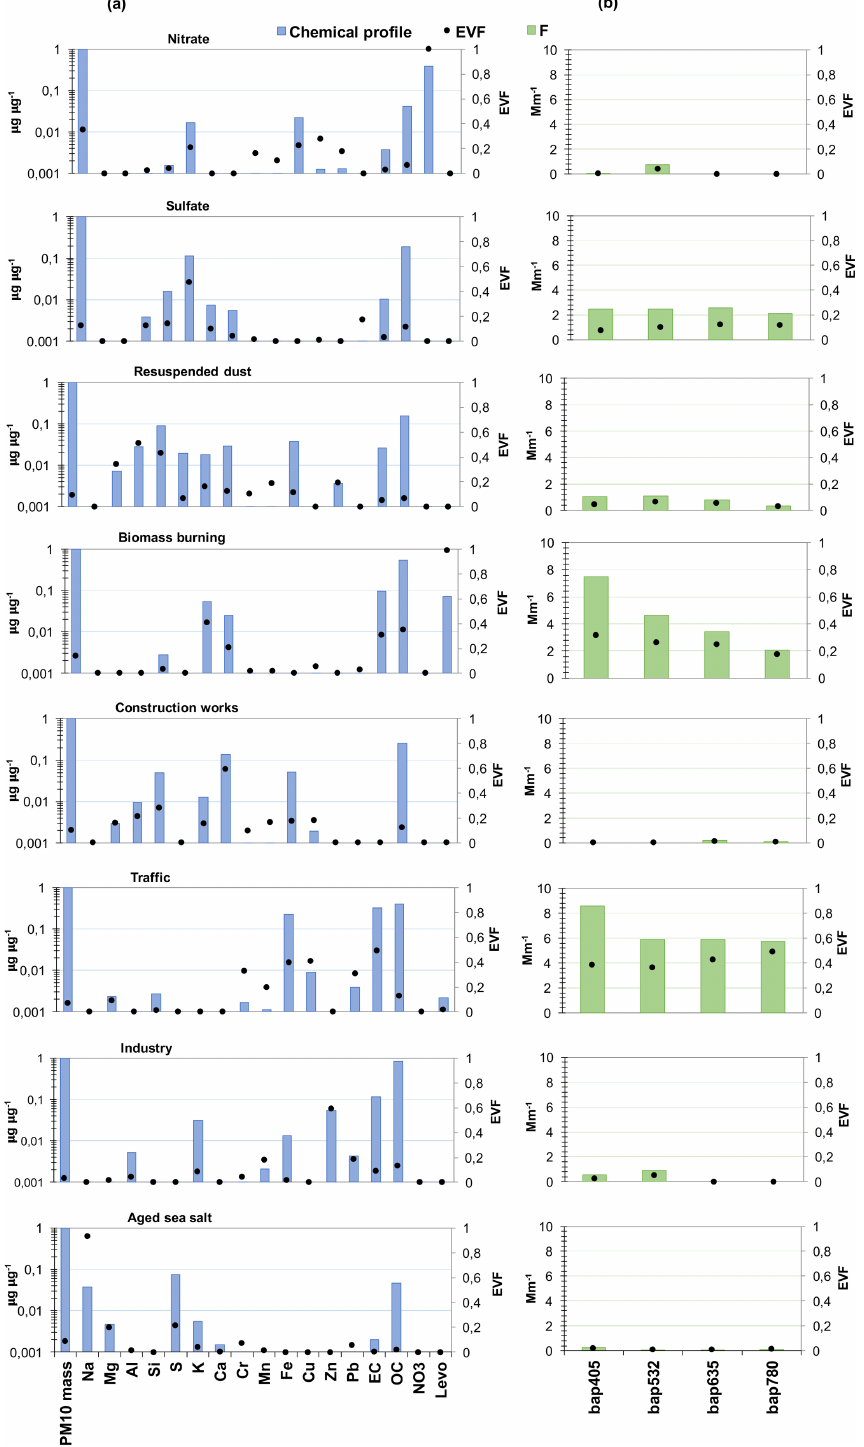
Figure 3. (a) Chemical profiles of the eight-factor constrained solution; (b) b ap apportionment of the eight-factor constrained solution. The blue bars represent the chemical profile (output of the matrix F normalized on mass), the green bars the output values of the matrix F for the optical variables, and the black dots the